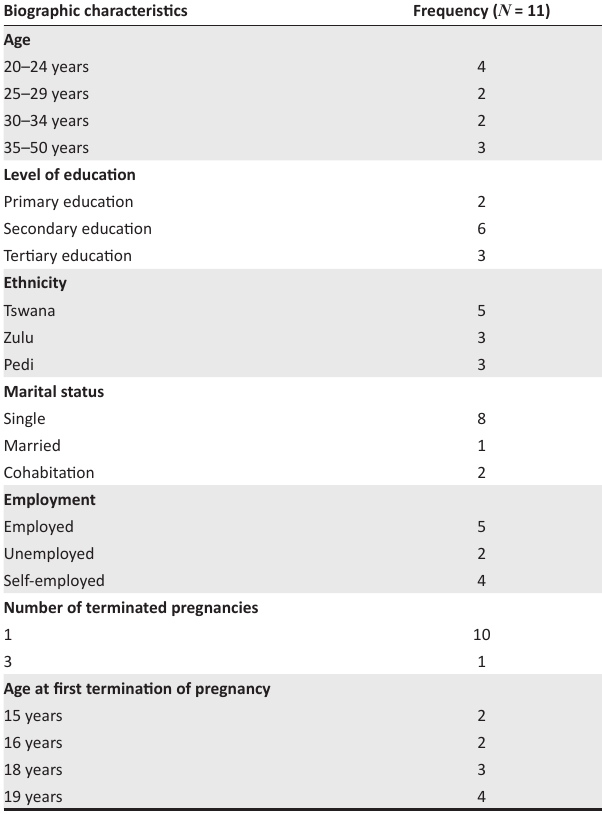
TABLE 1: Biographic characteristics of